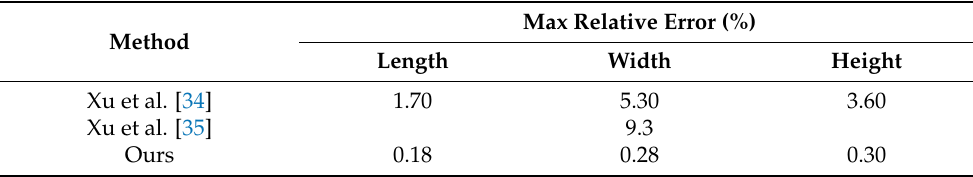
Table 4. The experimental results of our measurement method and the to main comparison